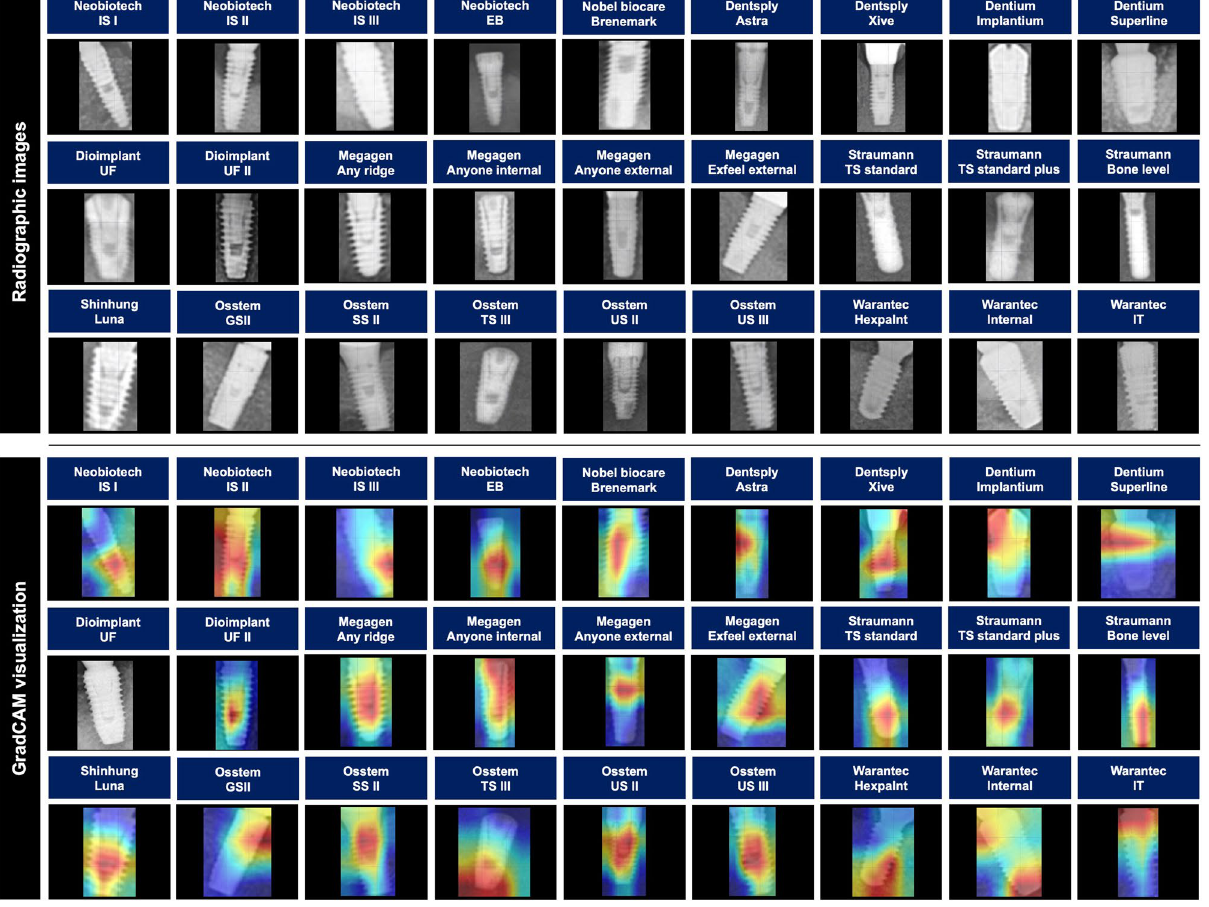
Figure 2. Dataset containing 116,756 panoramic and 40,209 periapical radiographic images and comprising 10 manufacturers and 27 types of dental implant